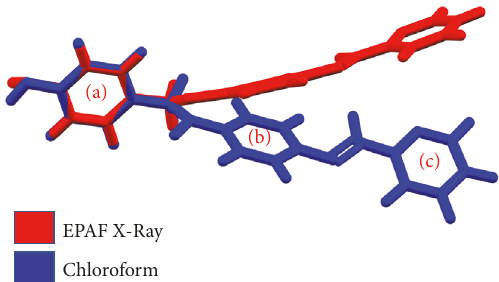
Figure 2: Overlap between the molecular structure determined by X-ray (in red) and in Chloroform (in blue). The ring (a) was used as